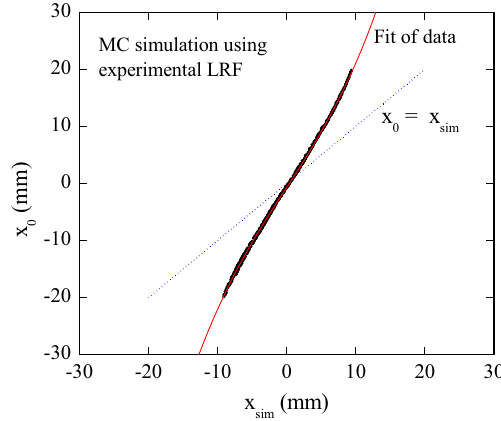
Fig. 18 Direct SiPM-matrix readout: true coordinate of interaction point x 0 as a function of reconstructed coordinate x sim (black dots), the latter obtained using MC simulation with the experimental LRF , and a fit of this dependence by polynomial function (red curve). For comparison, the dependence x 0 = x sim is shown (blue dotted line)